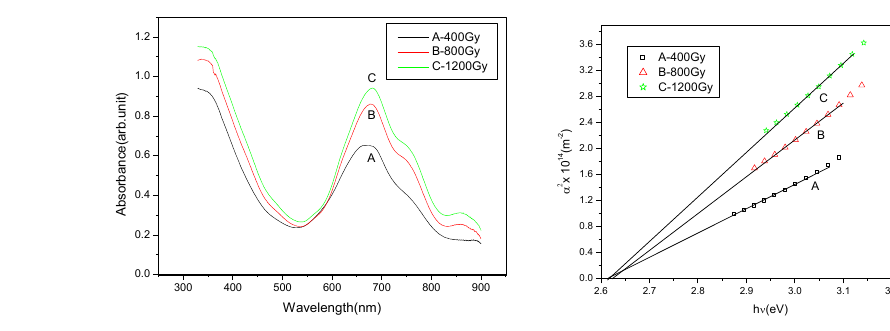
Figure 7 . optical absorption spectra of Figure 8 . Plot of α 2 versus photon energy Cl FePc thin films irradiated with various hν for γ- irradiated Cl 16 dosages. films at different dosages.